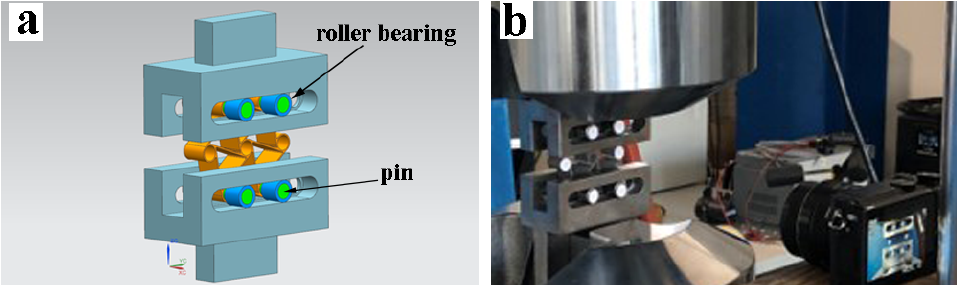
Figure 6. Test setup for cyclic loading showing ( a ) the design and illustration of text fixture and test layout ( b ) produced text fixture and experimental layout.